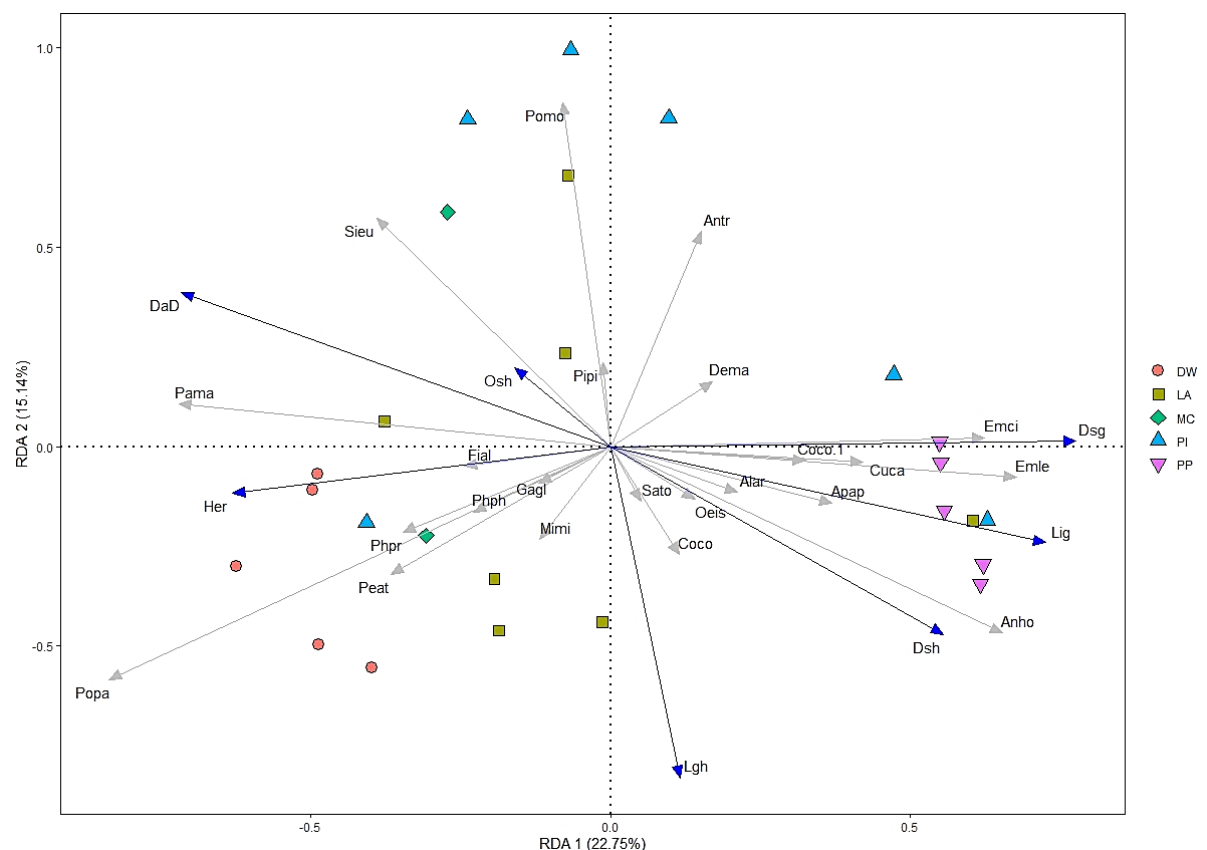
Figure 5. Redundancy analysis (RDA) ordination among bird assemblage and habitat types and environmental variables in the forest of the Khentii Mountains. Forest types are deciduous wood- land (DW), larch (LA), pine (PI), pine plantation (PP), and mixed conifer (MC). Note: Species and habitat structural variable names are generic acronyms or the four or three letters of the names in Tables 1 and 2.